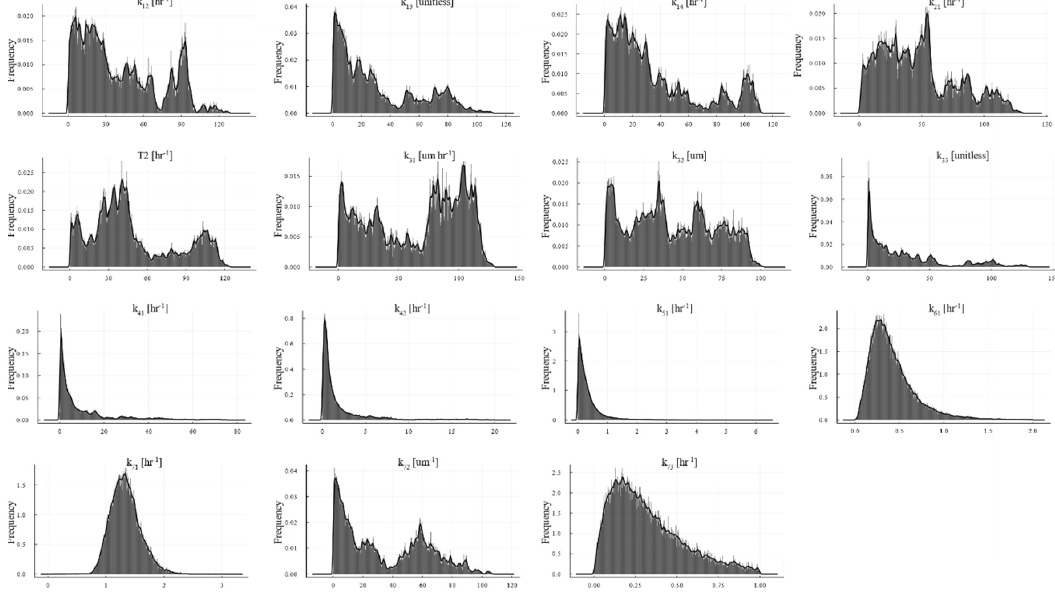
Figure 4. MCMC Parameter Histograms. Note: non-normal distributions for several parameters.